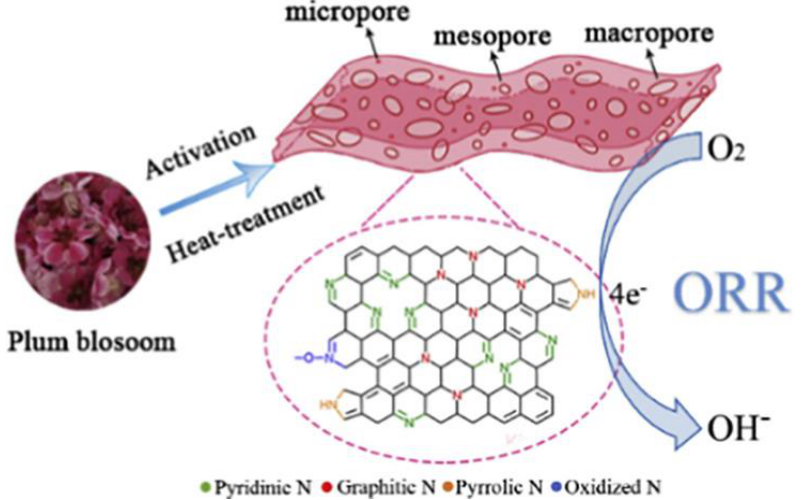
Figure 14. Illustration of a nitrogen-doped porous carbon material prepared from fallen plum blossom via chemical activation and post-treatment and studied as the electrocatalyst for oxygen reduction reaction. Adapted with permission from ref. [98].